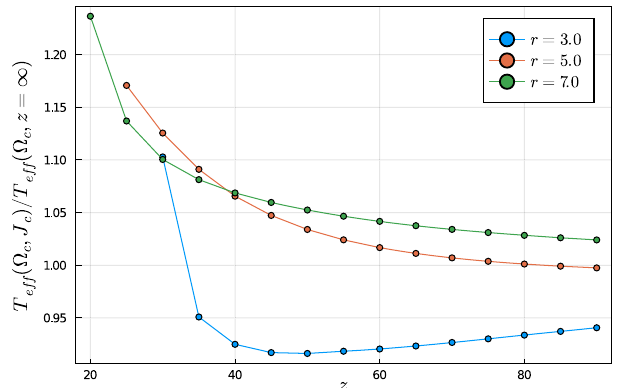
FIG. 12. Change of the effective temperature T at the critical eff ; J point ð Ω as a function of lattice connectivity z , with respect c c Þ to its mean-field value at z ¼ ∞ , for different values of the pump- to-loss ratio r . We see that the relative change in T remains of eff the order of a few percent up to connectivity z ¼ 50 and slightly increases up to 20% for the lowest connectivity z ¼ 20 . This result should be compared to the DMFT renormalization of the critical hopping for similar values of drive and connectivity, which is instead much stronger as shown in Fig. 2. In particular, for z ¼ 30 and r ¼ 3 the critical hopping is pushed to infinity corresponding to a complete destruction of the normal phase. 14 Parameters: dim H ¼